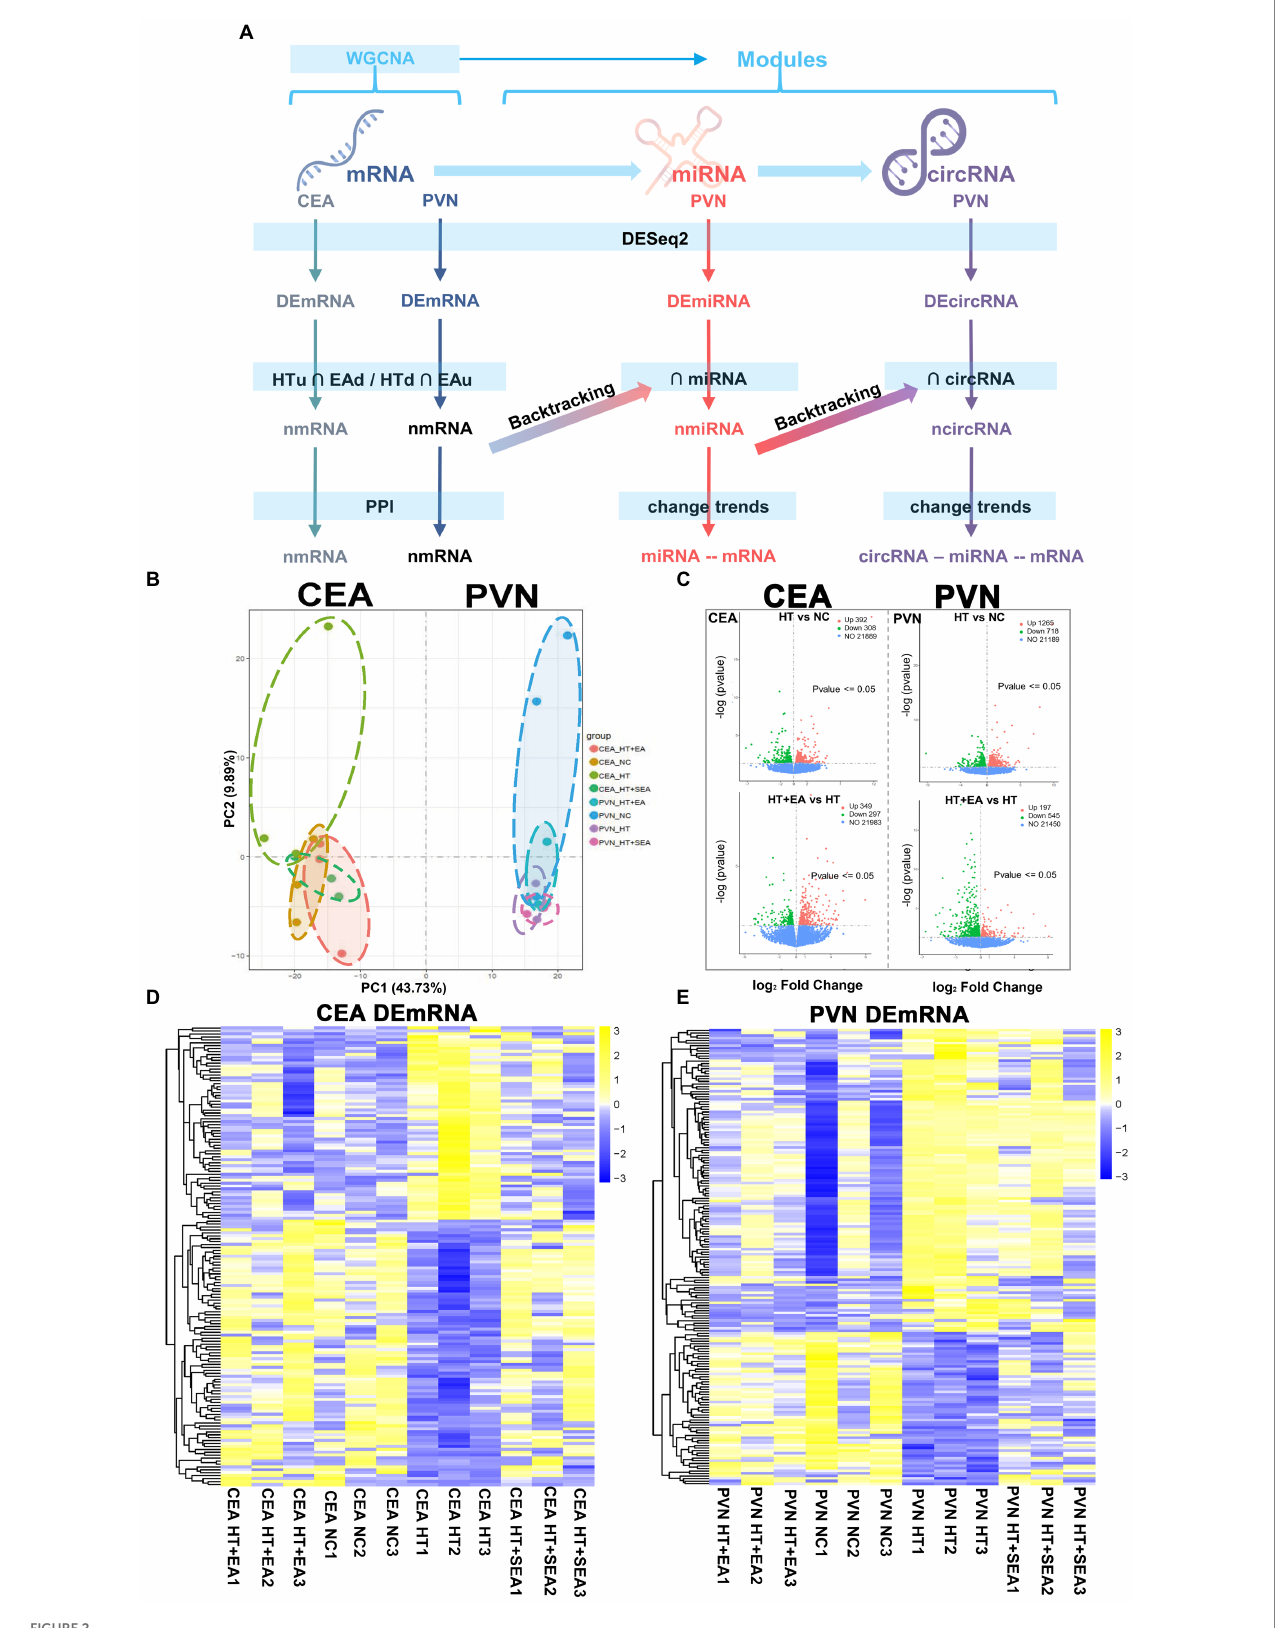
FIGURE 2 EA at Zusanli (ST36) and Sanyinjiao (SP6) altered the gene expression patterns in the CEA and PVN. (A) Flow chart of the analytical process from raw RNAseq data. (B) PCA of the CEA and PVN. (C) Volcano plots of transcribed genes with a p value < 0.05 and |log 2 (Fold Change) | > 0. (D,E) Cluster heatmap of DEmRNAs in the CEA and PVN. Data is available from NCBI GEO: GSE214276, GSE214277, GSE214278, and